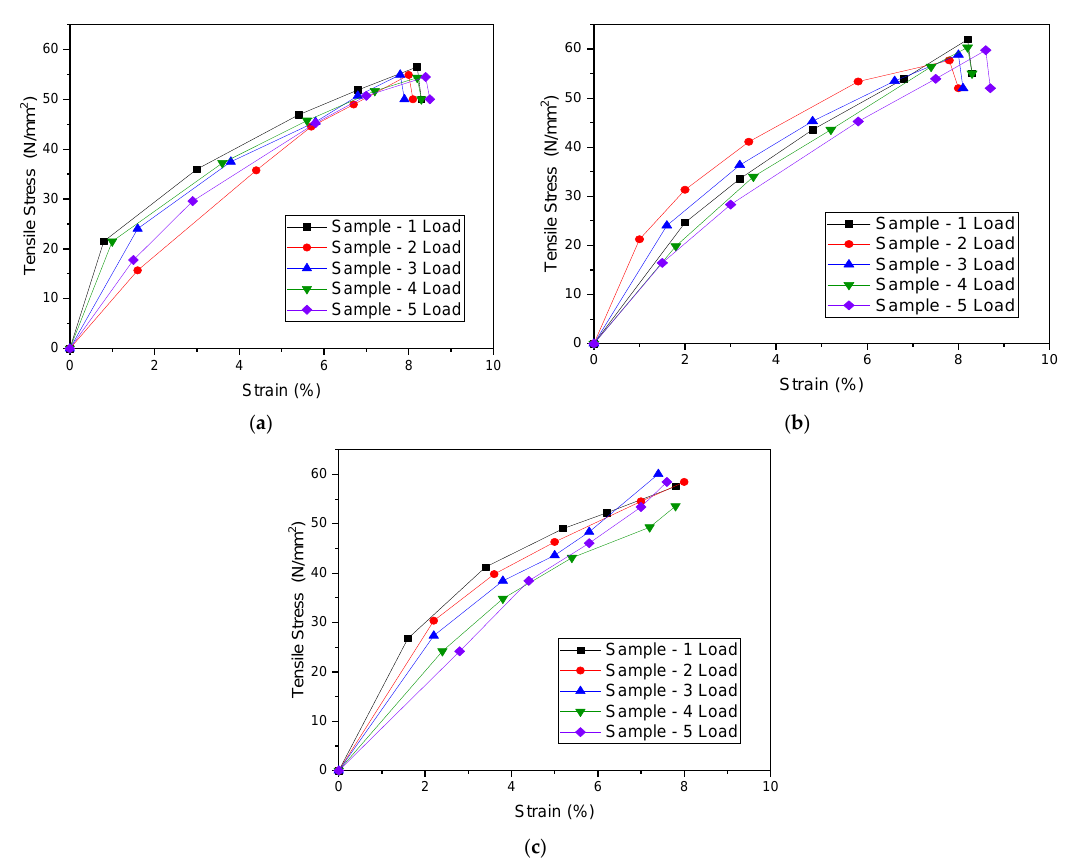
Figure 5. Tensile stress–strain curves for ( a ) 0.1, ( b ) 0.5, and ( c ) 1.0 wt.% COOH-MWCNT in PMMA. The stress–strain curves for non-functionalized and f-MWCNT/PMMA nanocompo- sites are shown in Figure 6, and the impact of wt.% on tensile strength is highlighted in Figure 7.